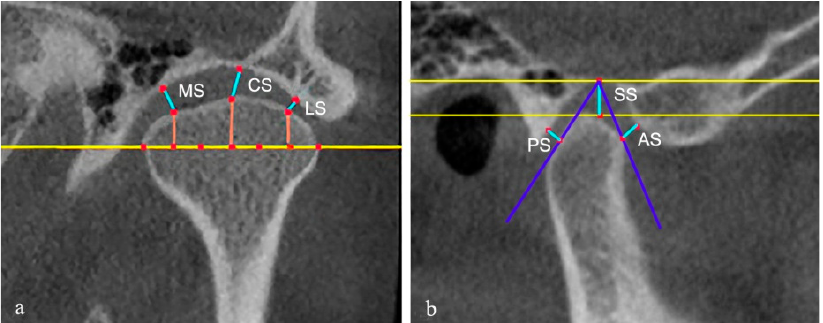
lateral space (LS), central space (CS), and medial space (MS) were measured using the method of Ikeda [21] (Figure 3).